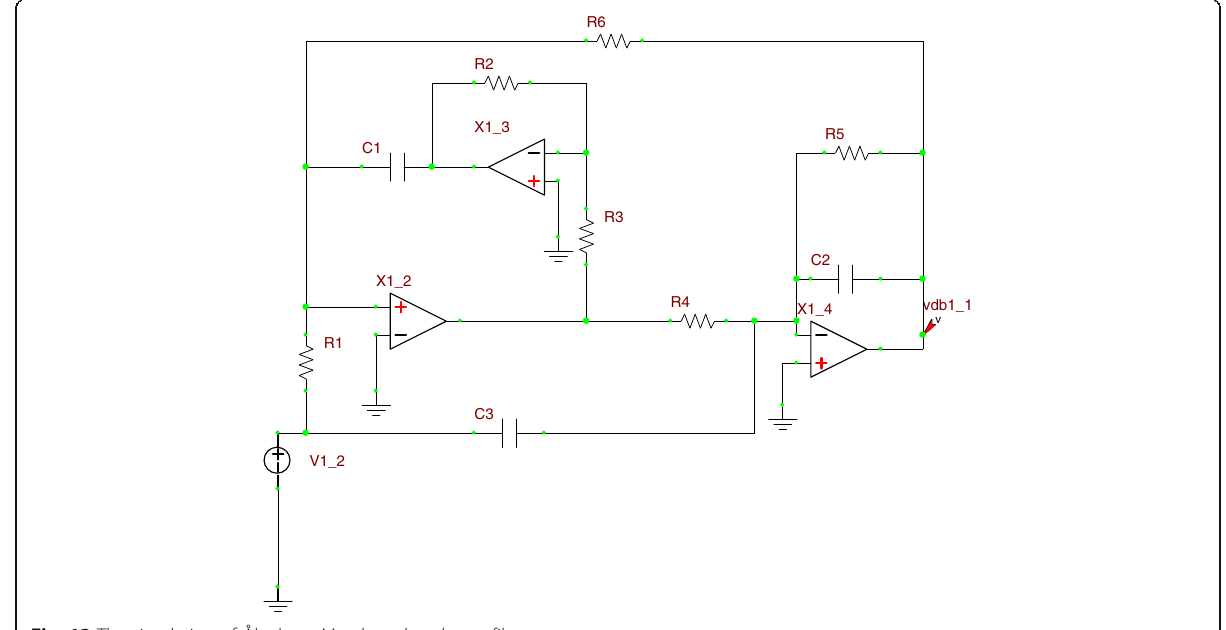
Fig. 13 The simulation of Åkerberg-Mossberg band-stop filter